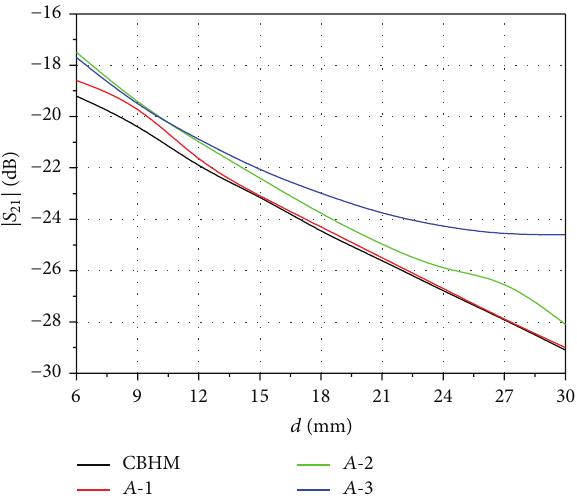
Figure 21: Graphics of |𝑆 21 | : side-by-side configuration.